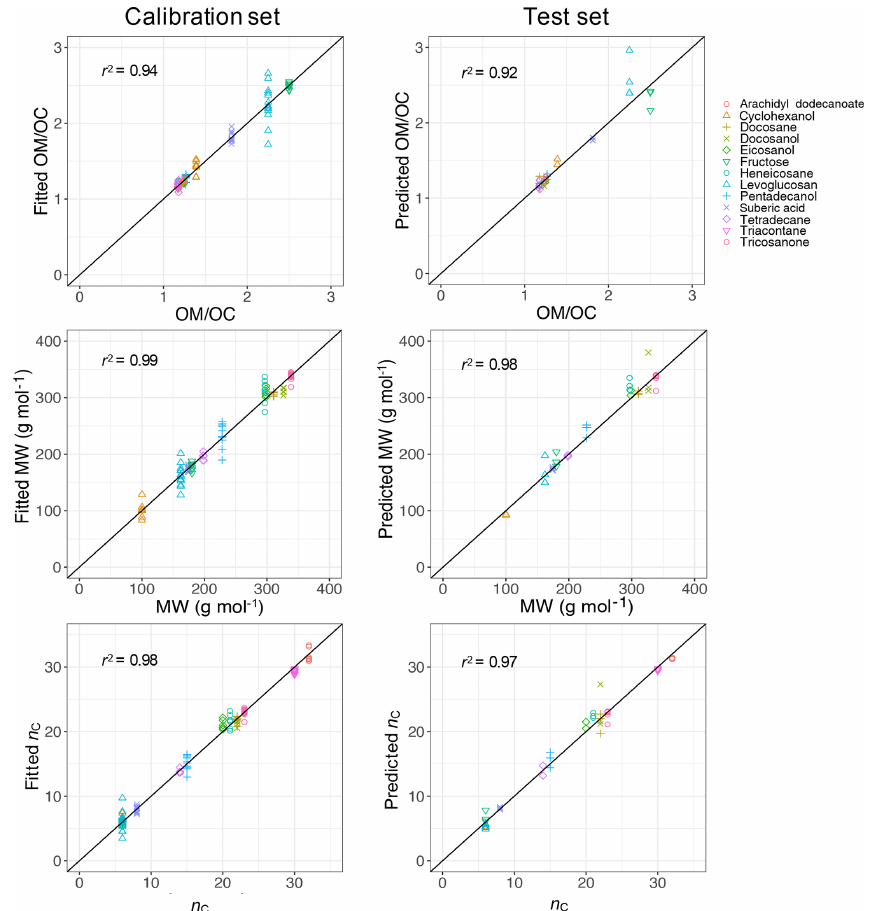
Figure 11. Scatter plot of fitted (predicted) indirect OM / OC ratio, MW, and n C against the values from chemical formula of the calibration set (test set). The diagonal black lines indicate the perfect fit (1 : 1).